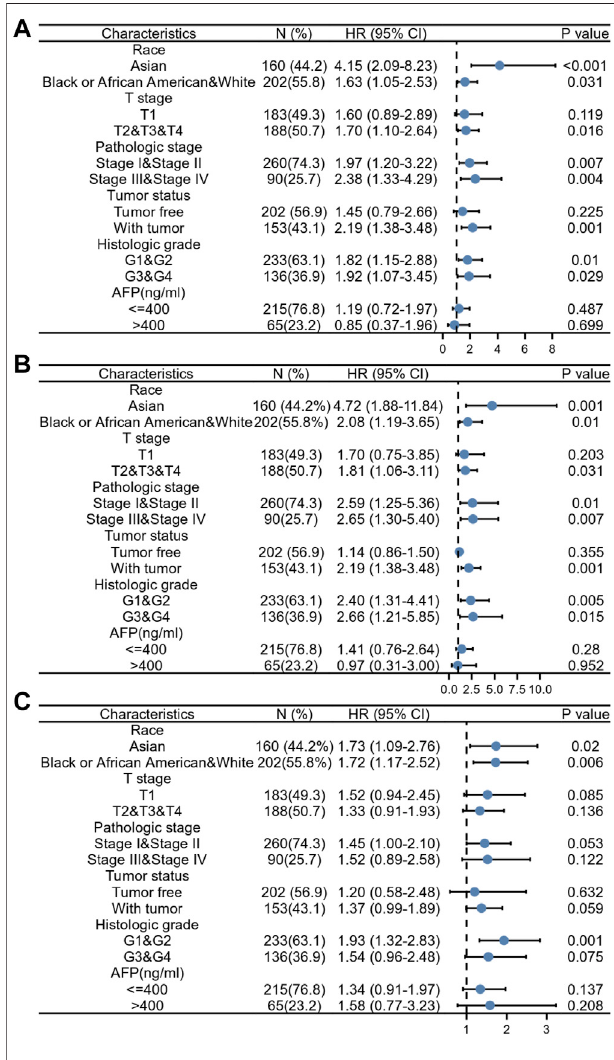
FIGURE 10 | Prognostic performance of EXO1 expression in different HCC patient subgroups. The HCC patients were divided into different subgroups based on race, T stages, pathologic stages, tumor status, histologic grades, and AFP levels. (A – C) The Cox regression analysis resultsshowtheprognosticperformanceofEXO1expressionlevelsregarding (A) overall survival, (B) disease-speci fi c survival, and (C) progression-free intervalindifferentsubgroups ofHCC patients.Theresults arerepresentedby the hazard ratio (HR). The bar represents the 95% con fi dence interval (CI) of the HR values and the size of the diamond represents the signi fi cance of the prognostic performance EXO1.